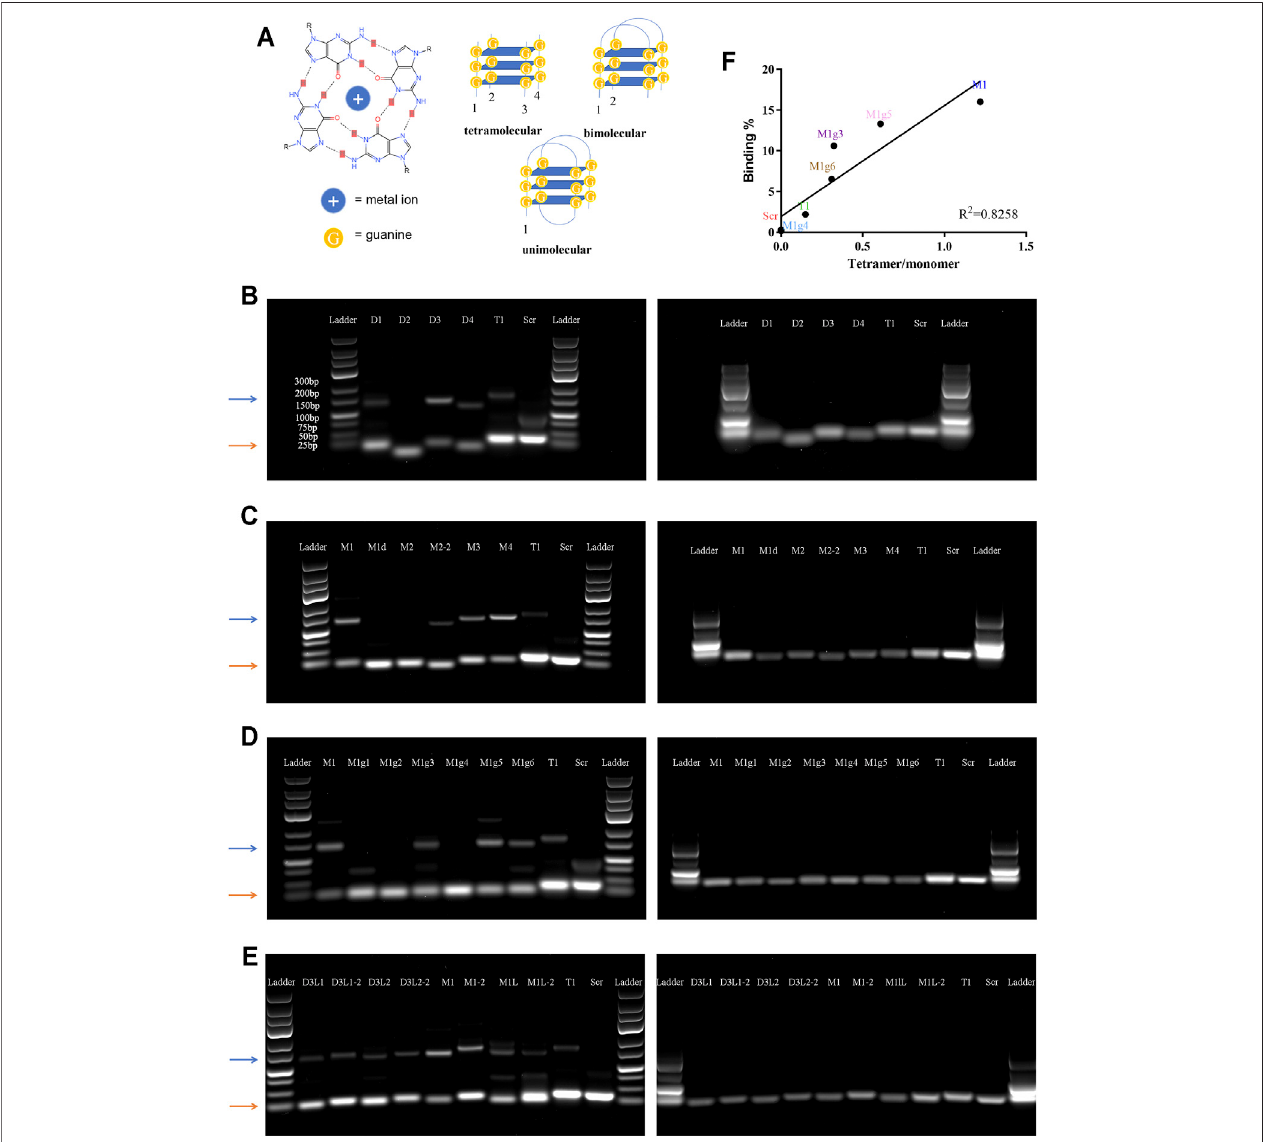
FIGURE 3 | Analysis of tetramolecular G-quadruplex. (A) Schematic view of special secondary structures of G-quadruplex. Left panel: molecular structure of a G-quartets. Right panels: Secondary structures of unimolecular, bimolecular, and tetramolecular G-quadruplexes. (B – E) Images of agarose gel electrophoresis results. Leftpanels: non-denatured gels; right panels: denatured gels. Orange arrows point tothe monomer bands, and blue arrows point to thetetramer bands. (F) Correlation between cell binding af fi nity and tetramer/monomer ratio.